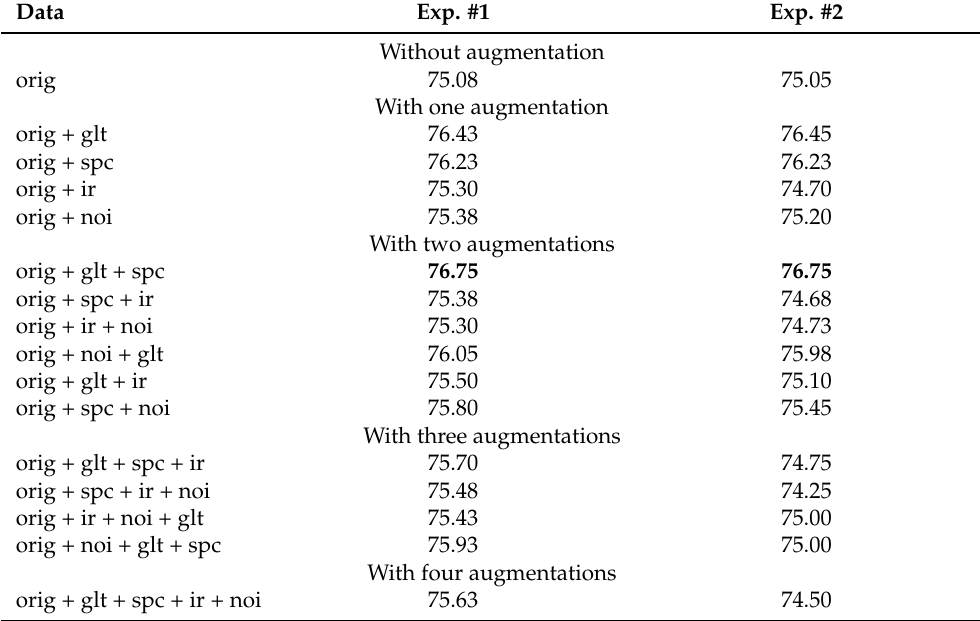
Table 3. Unweighted average recall (UAR, %) of SER with different data augmentation techniques on JTES-TI . orig = original JTES dataset, glt = glottal source extraction, spc = speech cleaned, ir = impulse response, noi = noise addition. The highest scores for each experiment are in